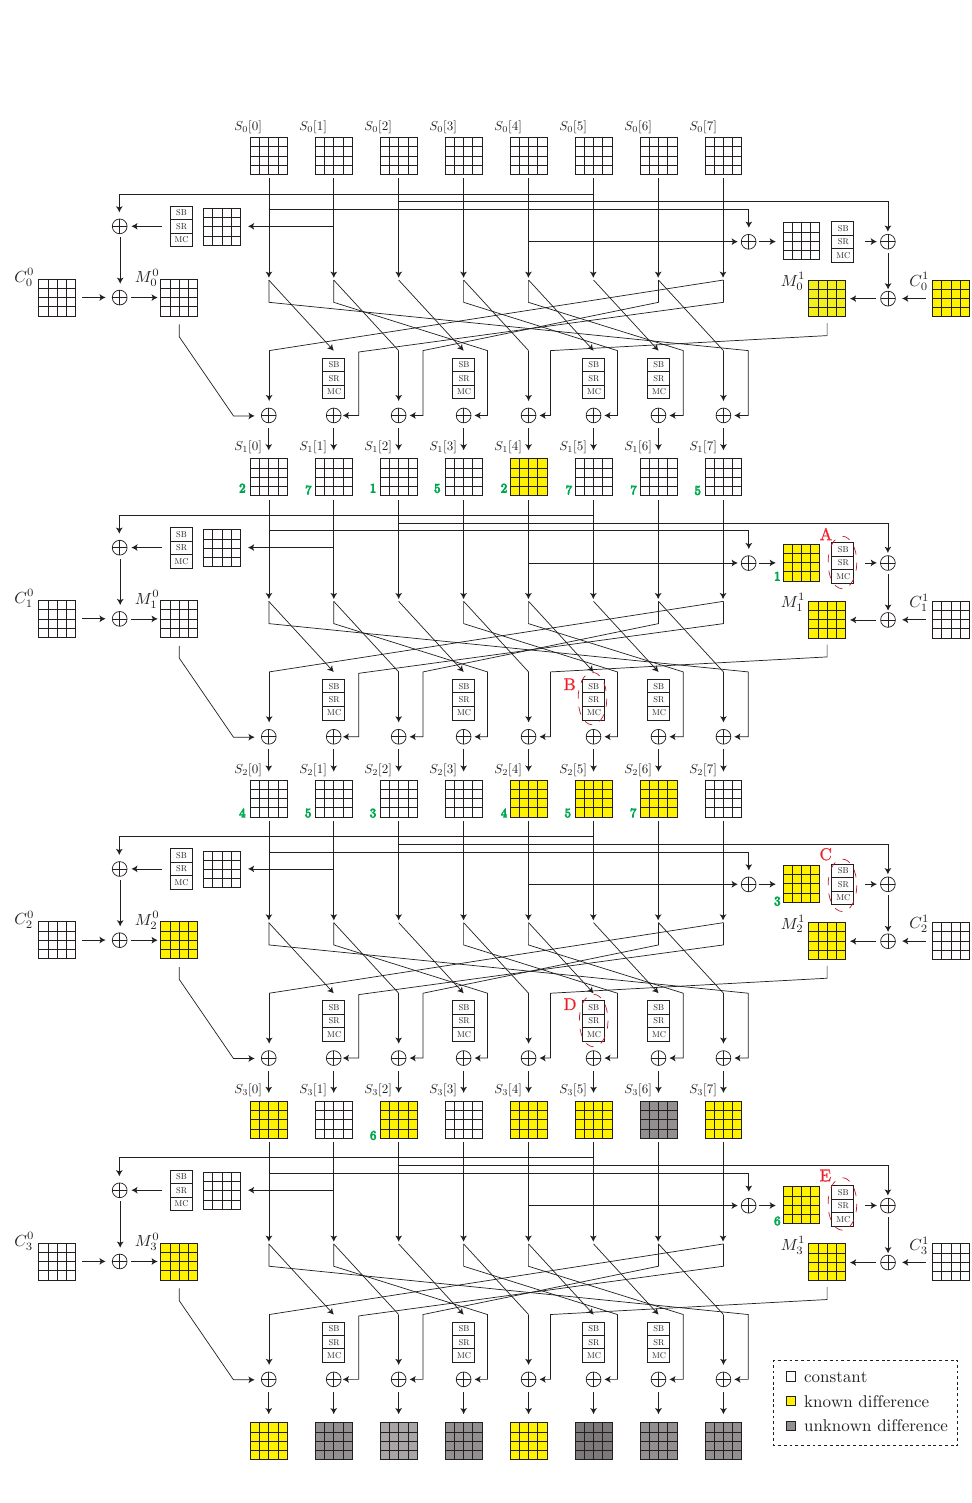
Figure 3: State recovery using one “nonce-repeated”